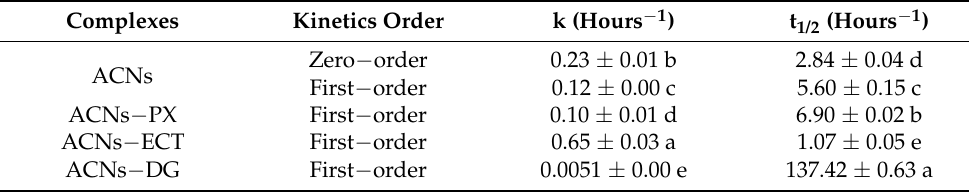
Table 2. Degradation kinetic parameters of anthocyanin